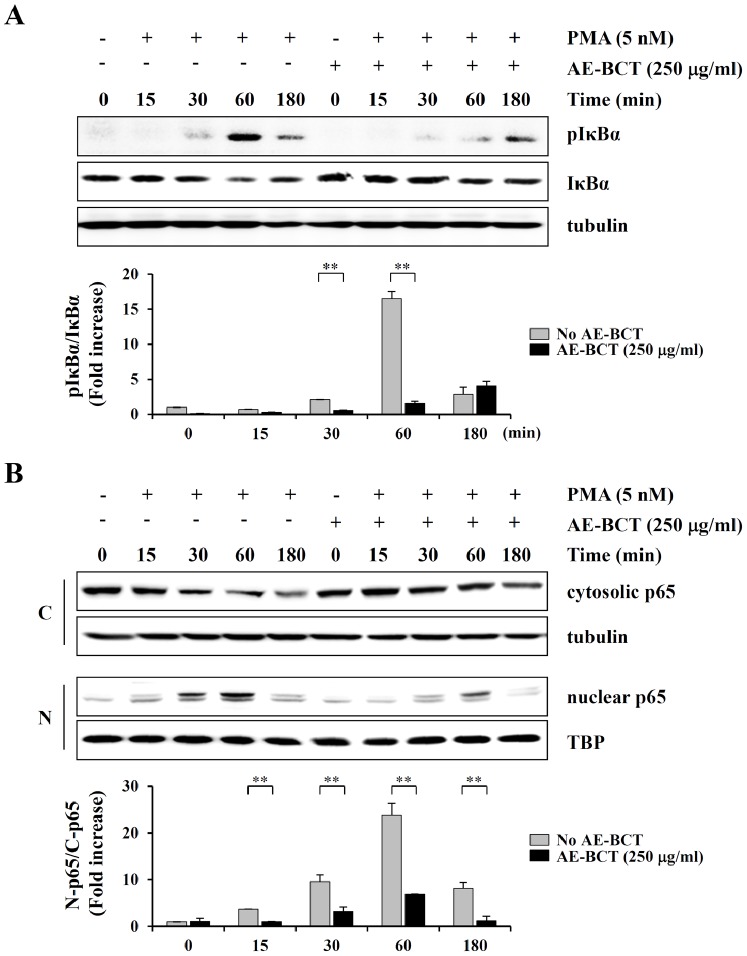
Effect of AE-BCT on NF-κB activation in HT1080 cells.(A) Control and AE-BCT-pre-treated HT1080 cells were stimulated with 5 nM PMA for the indicated periods of time and cell lysates were subjected to Western blotting of the phosphorylation and degradation of IκBα. (B) To examine the nuclear translocation of the NF-κB p65 subunit in response to PMA stimulation, cell lysates were fractionated into cytosolic and nuclear compartments, and subjected to Western blotting. After normalization to α-tubulin or TBP expression, relative ratios of pIκBα/IκBα and nuclear p65/cytosolic p65 were determined. Data are expressed as means ± SD of two independent experiments. **p<0.01 vs no AE-BCT.